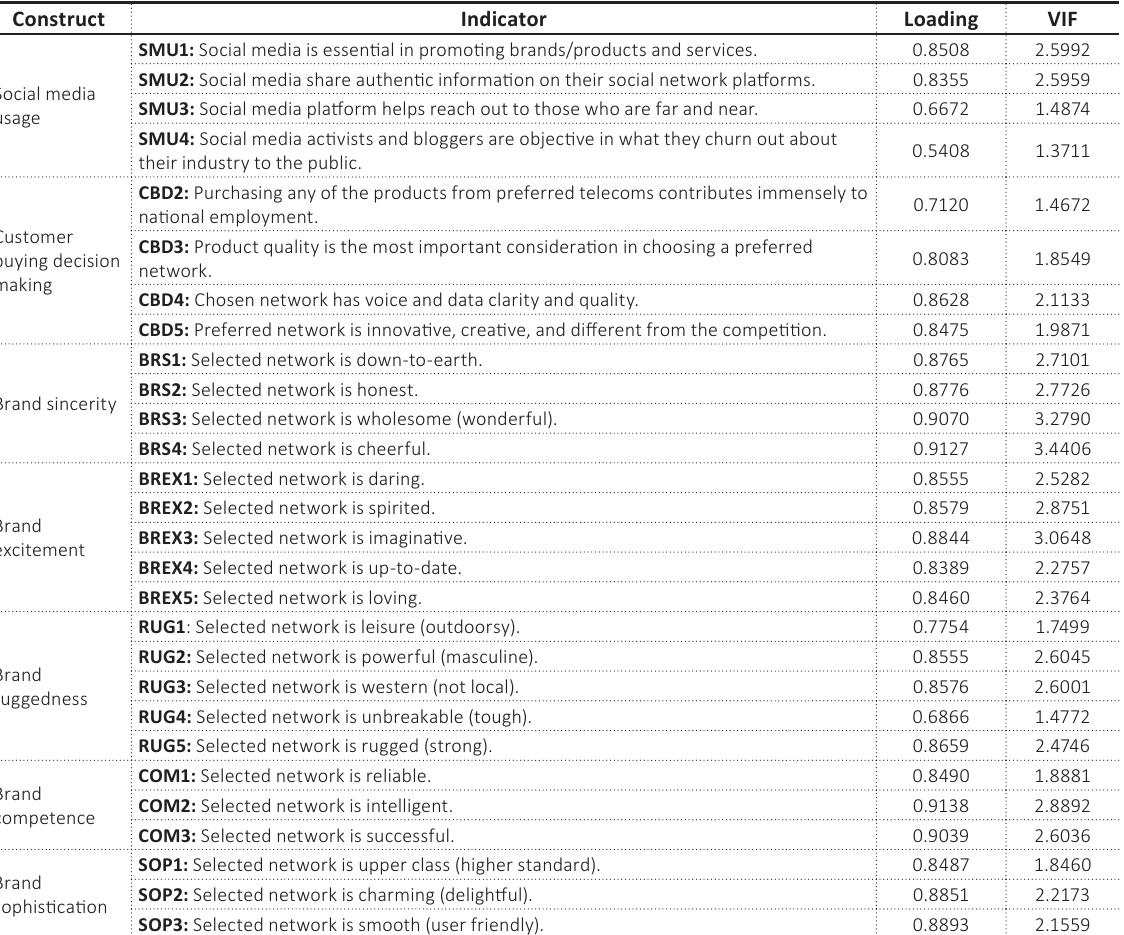
Source: Authors’ processing from ADANCO 2.2.1